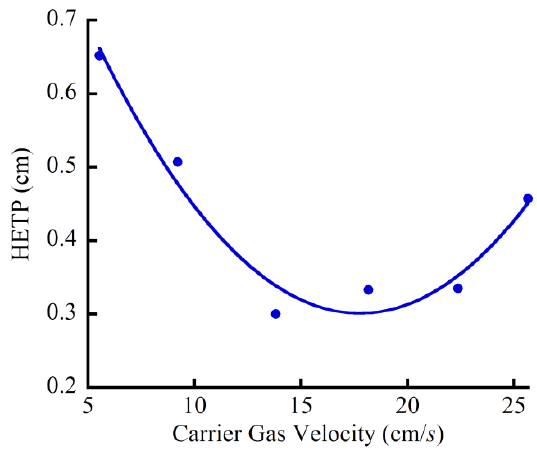
Figure 5. Golay plot of the relationship between the separation efficiency of the monolithically integrated GC column and the carrier gas flow